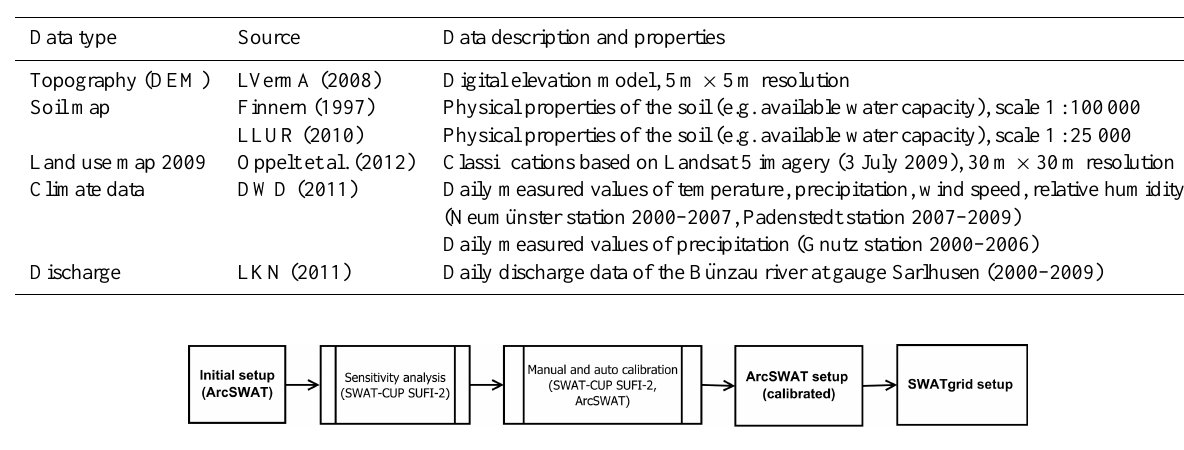
Table 1. Model input data sources.